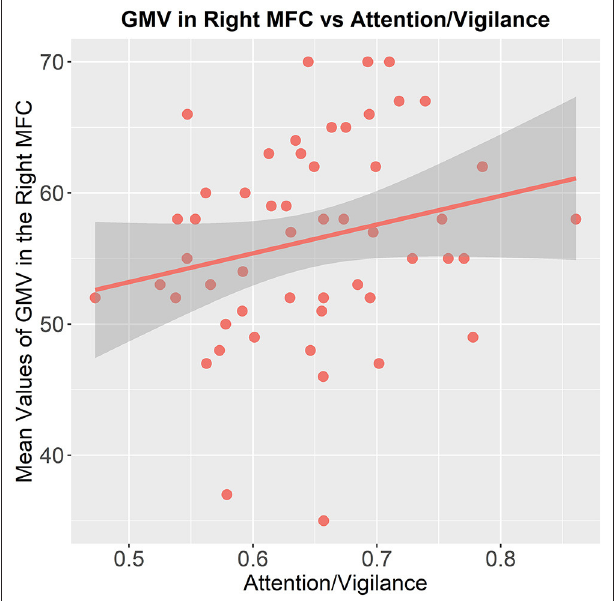
FIGURE 3 | Association between the GMV of the brain region and cognitive functioning. The mean values of GMV in the right middle frontal cortex are correlated to the attention/vigilance function in patients with MDD ( p = 0.014, partial. r = 0.349, controlling for age, gender, and education, without Bonferroni